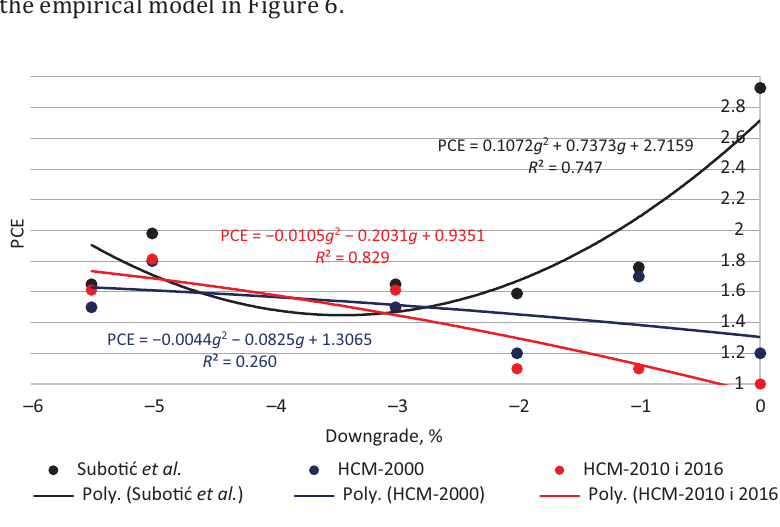
Figure 6. Comparative analysis of the PCE values with HCM-2000, HCM- 2010 and HCM-2016